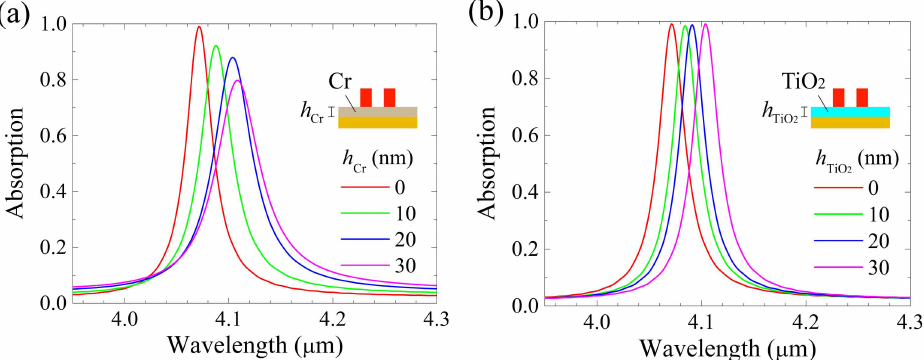
Figure 8. ( a ) Simulated absorption spectra with di ff erent thicknesses of the Cr adhesion layer. ( b ) The same as ( a ) but the adhesion layer is TiO 2